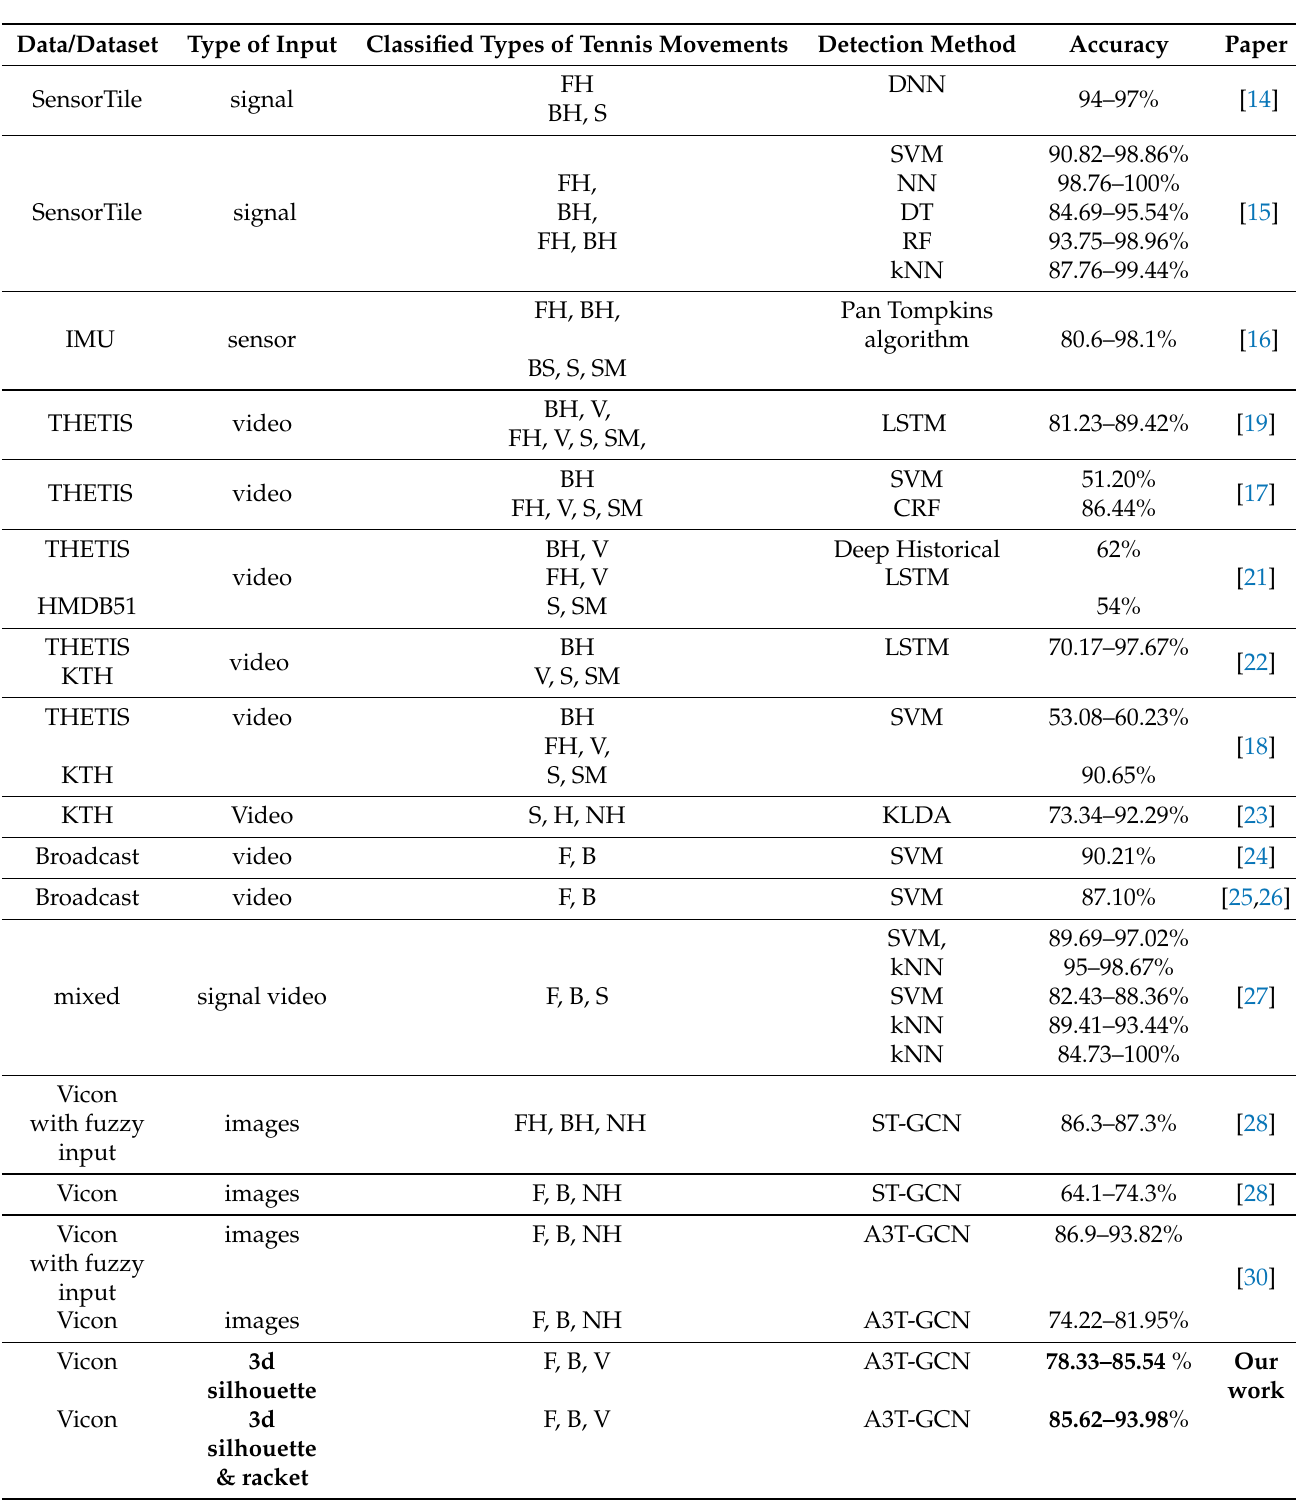
Table 7. Results comparison with the state-of-the-art. FH—forehand, BH—backhand,